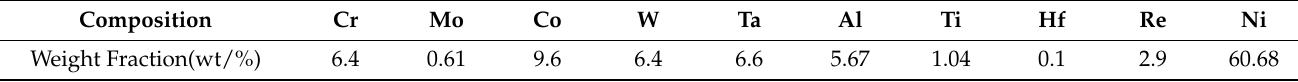
Table 2. Chemical composition of CMSX-4 Superalloy.